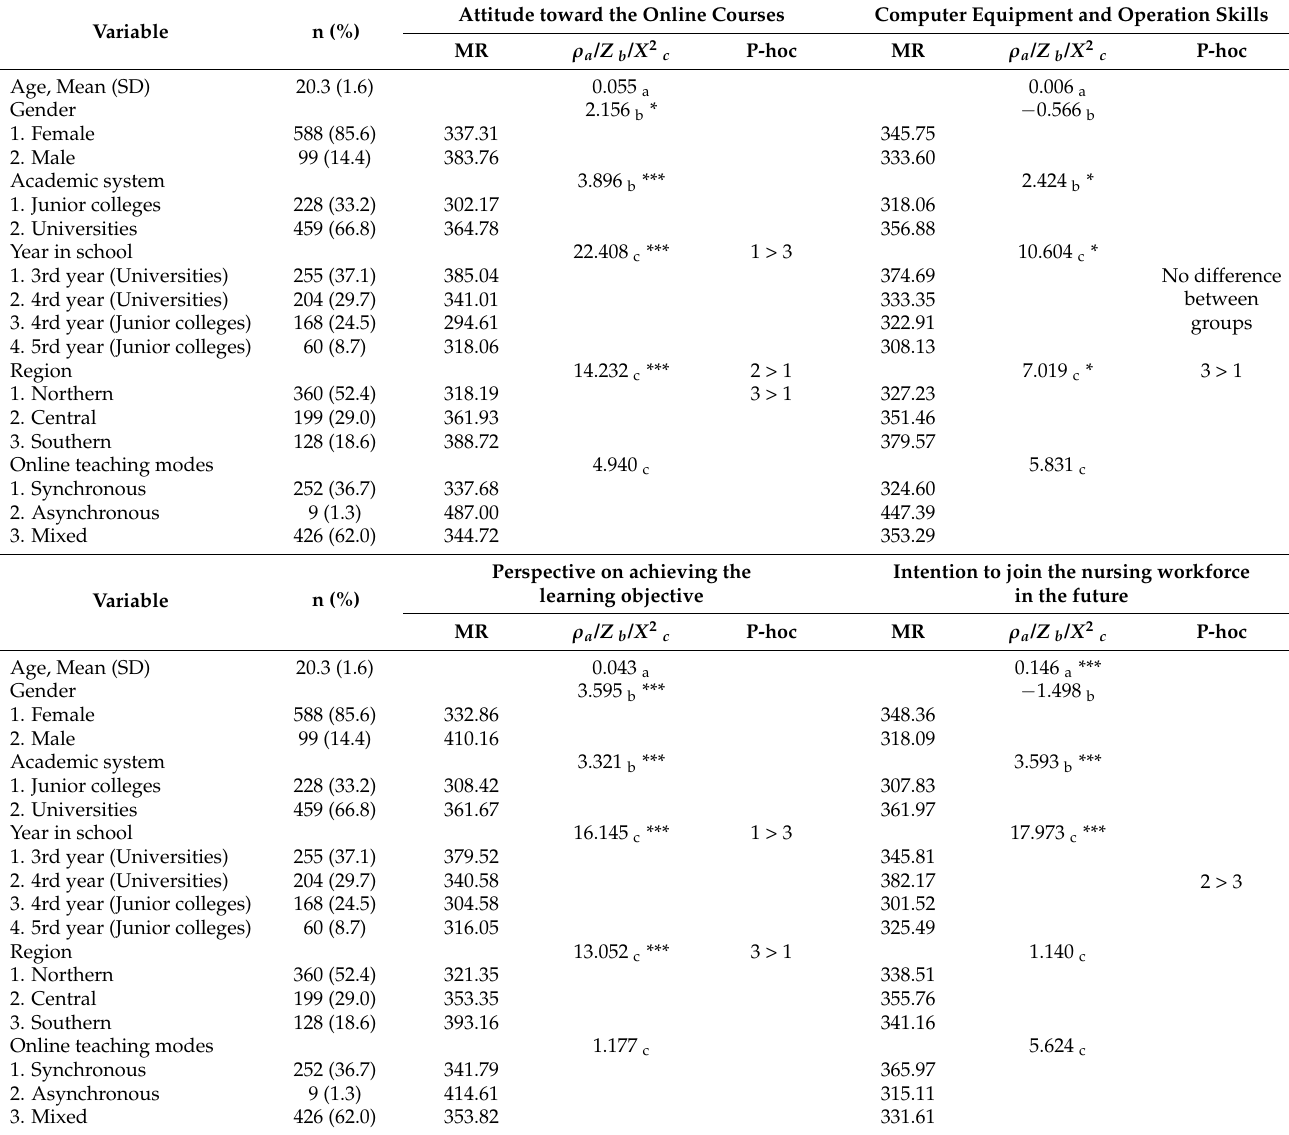
Table 1. Analysis of differences between demographic characteristics of participants and various scales (n =